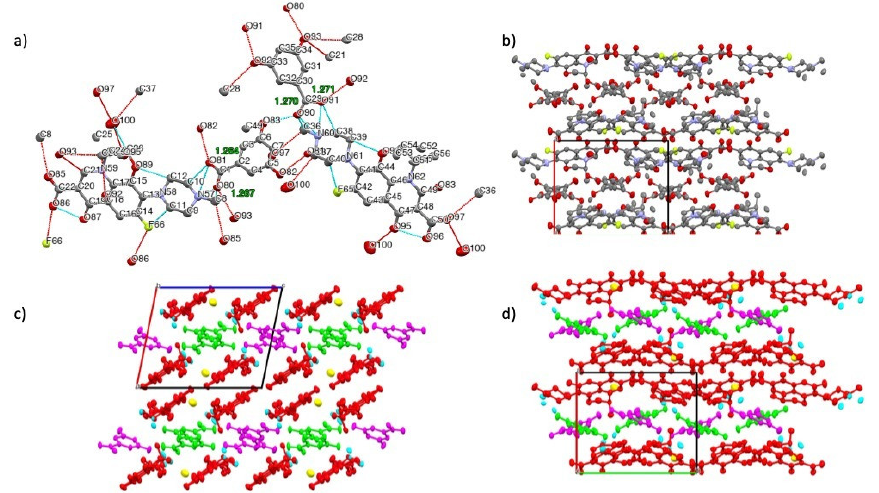
Figure 9. ( a ) Thermal ellipsoid drawing with atomic labeling scheme of LF-35 at 50% probability level. The dashed blue lines indicate intramolecular hydrogen bonds, while the dashed cyan lines indicate intermolecular hydrogen bonds. ( b ) Packing motifs of LF-35 along the a -axis, hydrogen atoms are omitted for clarity. ( c ) Packing motifs of LF-35 along the b -axis and ( d ) a -axis with symmetry coloring. The red color indicates LF molecules, while the magenta and green color indicate 3,5-DHBA molecules.